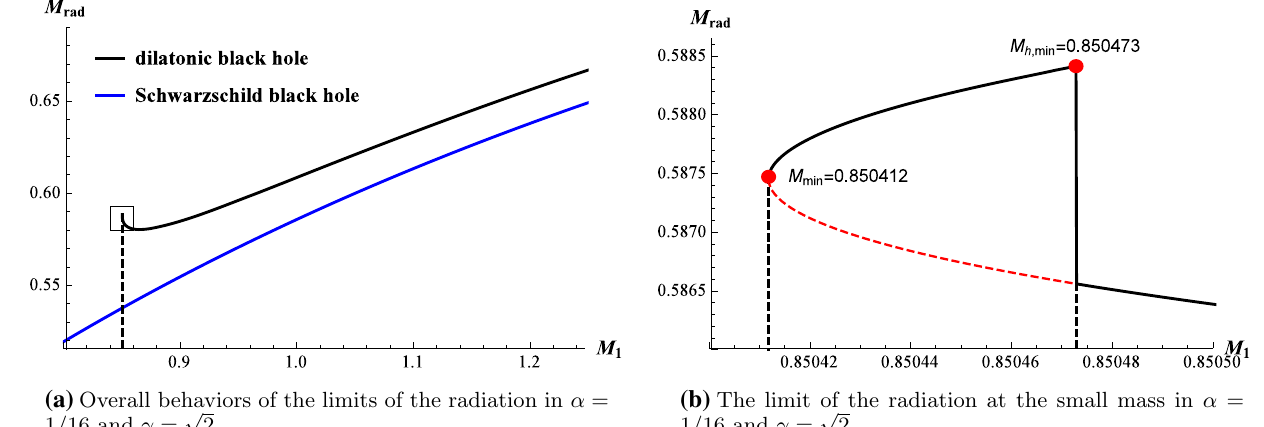
(b) The limit of the radiation at the small mass in α = √ 1 / 16 and γ = 2.